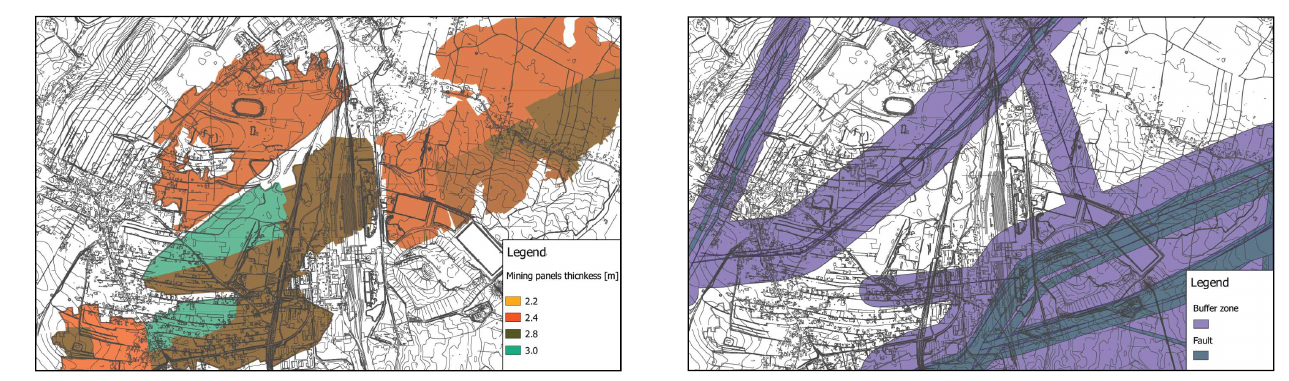
Figure 1. Thickness of the mining panels.